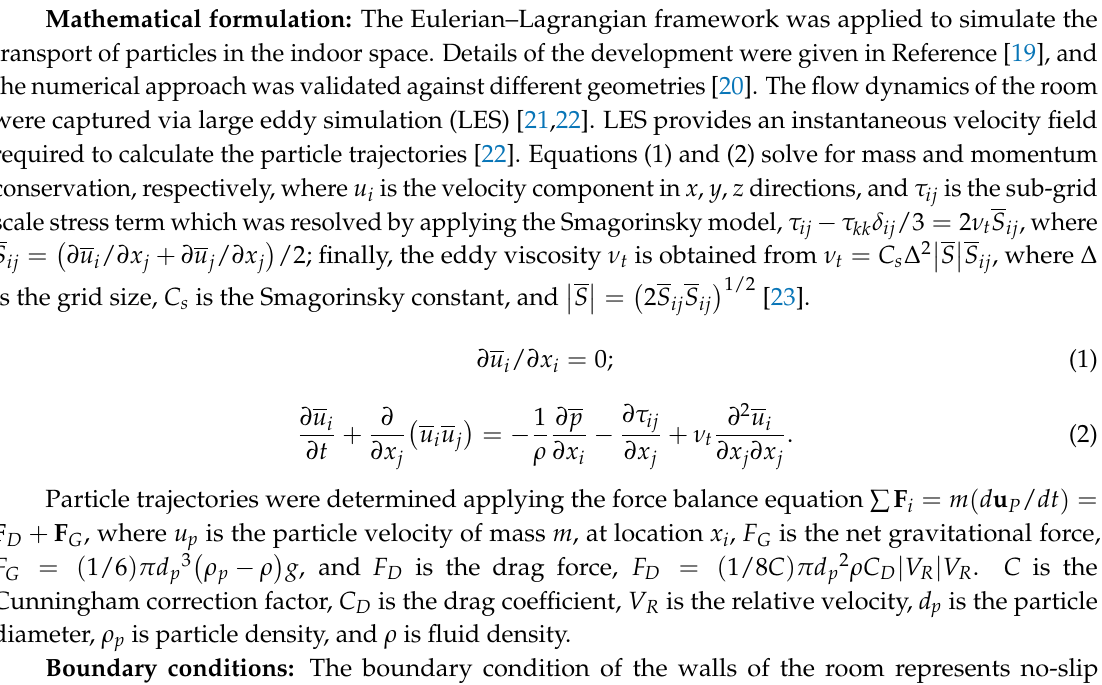
Figure 1. Problem scenario : ( a ) partition only; ( b ) partition and desks. Dimensions are in meters.